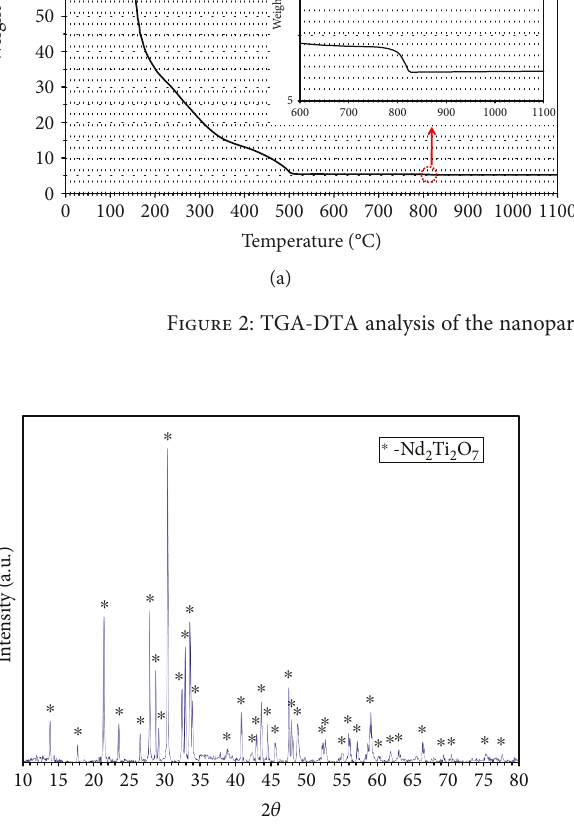
Figure 3: XRD pattern of the Nd